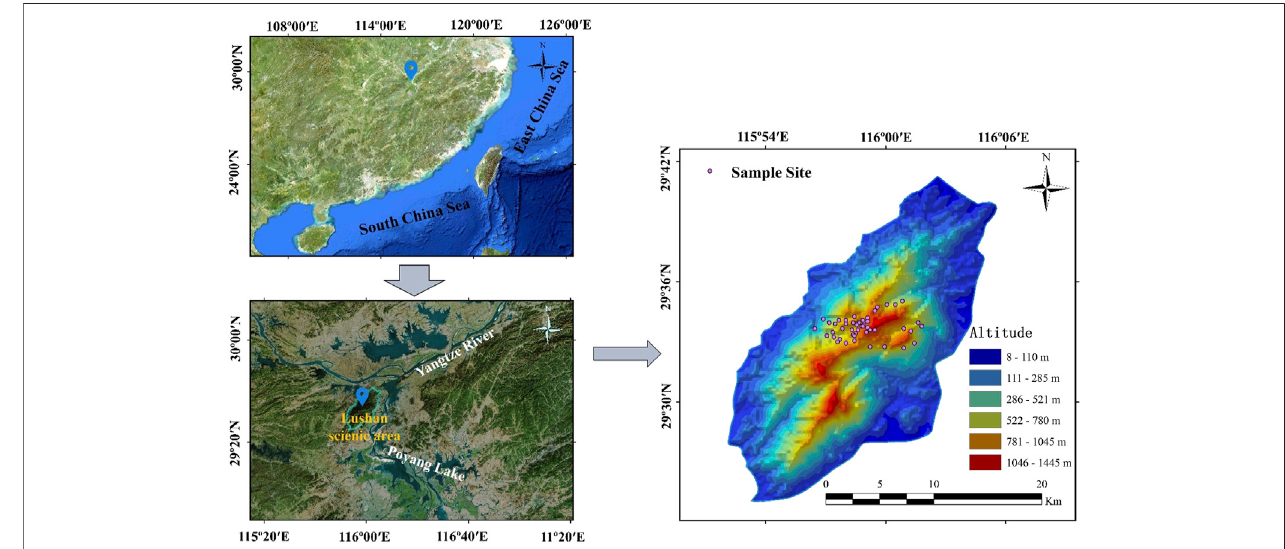
FIGURE 1 | Distribution of samples in Lushan scenic